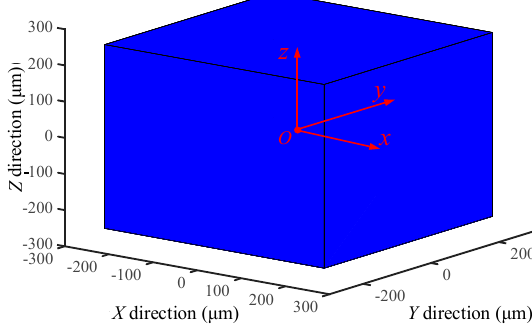
Figure 14. The reachable movement workspace.